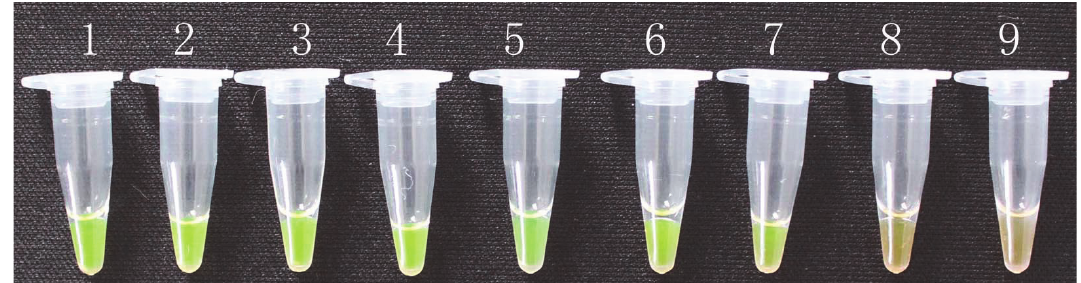
Figure 5: Limit of detection of LAMP assay. Tubes 1–9: nine 10-fold dilutions of purified DNA with concentrations ranging from 1fg to 100 ng per microliter (tubes 1 to 9 in order) were tested. The limit of detection of LAMP assay was 0.1pg ⋅𝜇 L −1 .